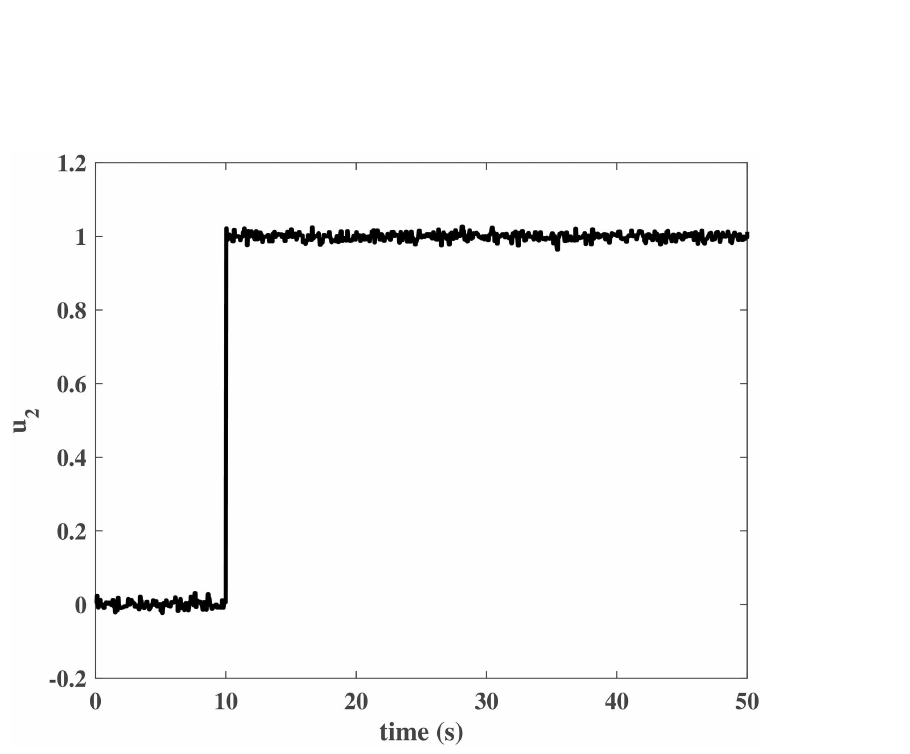
Fig 16. Controller output u 2 in the HIL